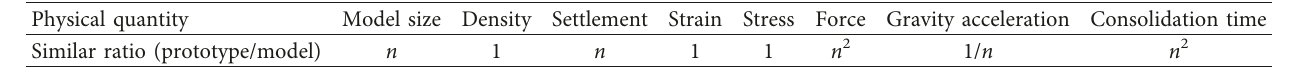
Figure 3: Testing equipment and instruments. (a) Test centrifuge. (b) Displacement sensor. (c) Settlement mark. (d) Combination diagram. (e) Pressure sensor. Table 2: The physical quantities’ similarity ratios used in centrifuge model